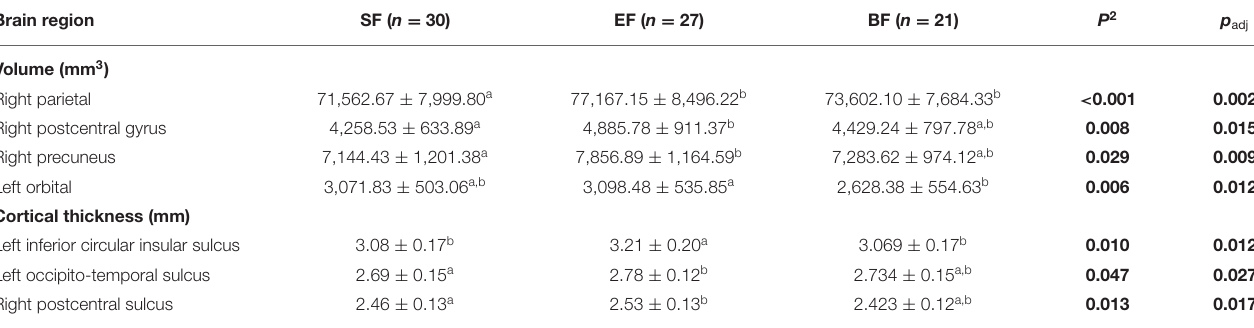
TABLE 3 | Differences in brain volume and thickness between 6 years old children fed with standard infant formula (SF), experimental infant formula (EF), or breastfed (BF) during their first 18 months of life 1 . Brain region